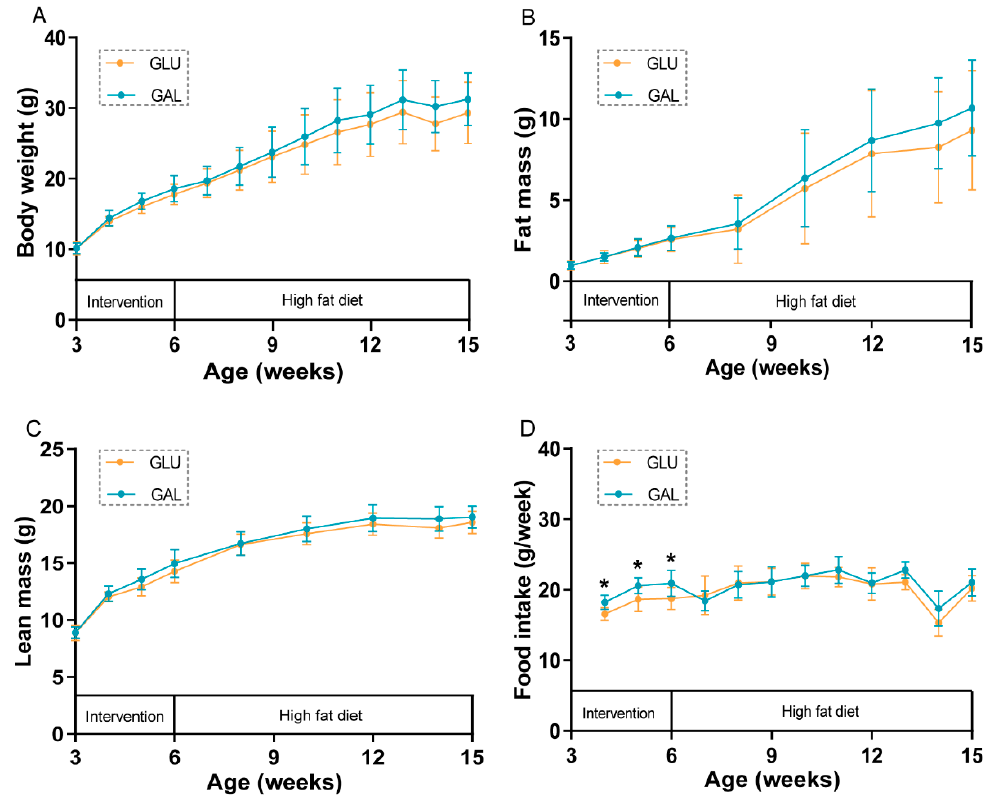
Figure 1. Body weight and body composition development, and food intake in GLU and GAL fe- male mice. ( A ) Body weight, ( B ) fat mass, ( C ) lean mass, and ( D ) food intake development during the intervention (aged 3–6 weeks) and consecutive high-fat diet (HFD) (aged 6–15 weeks) periods. Values represent mean ± SD, n = 13–14. * p < 0.05.